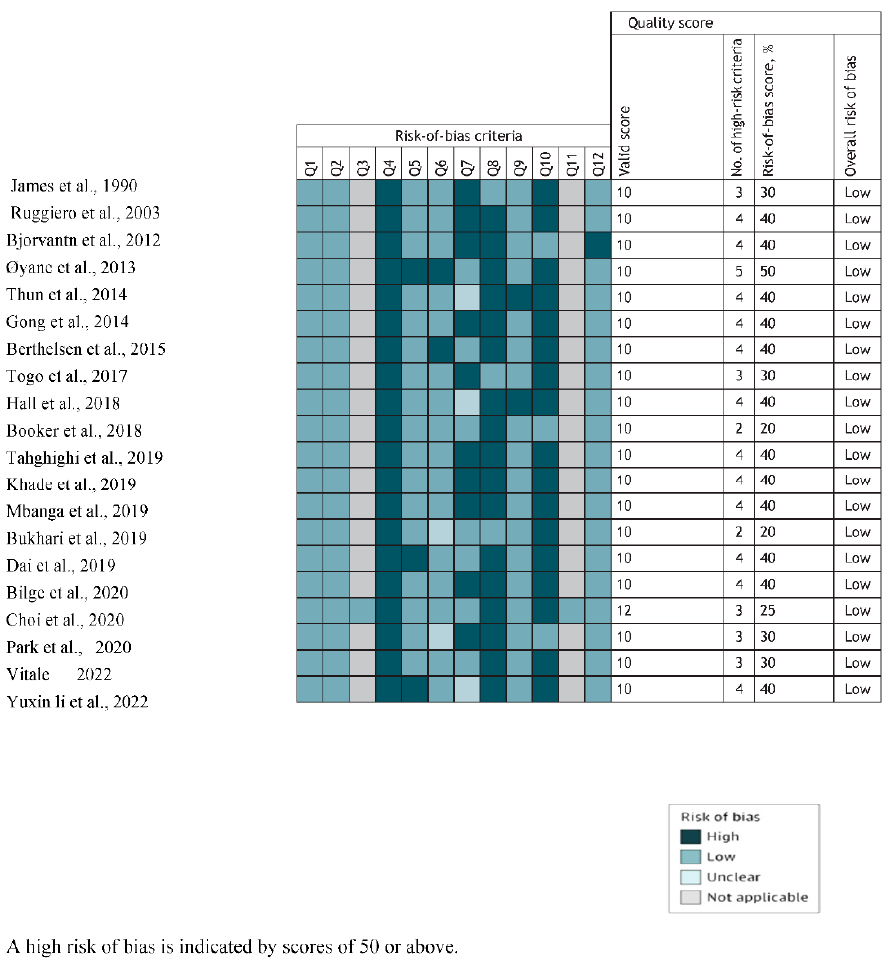
Figure 2. The included studies’ risk of bias as determined by the Research Triangle Institute Item Bank